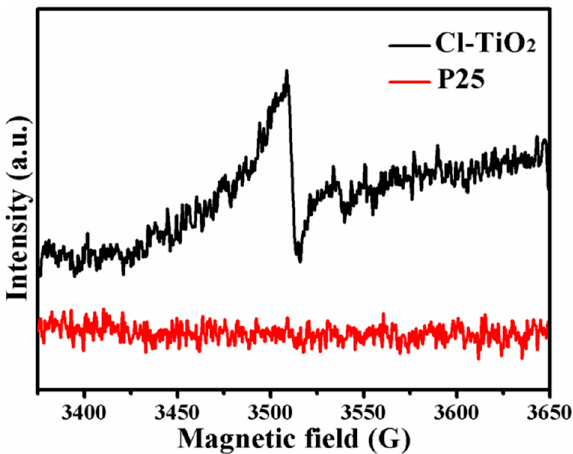
Figure 7. EPR spectra of P25 and Cl-TiO 2 .